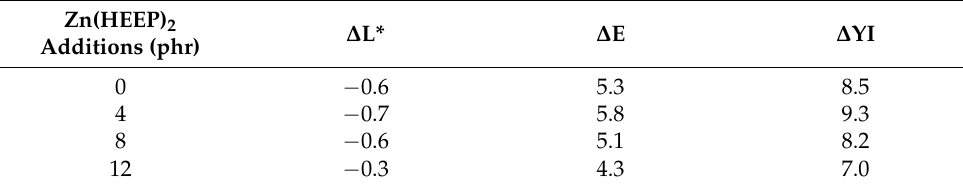
Figure 7. The Tan δ curves of UV films with different Zn(HEEP) 2 additions. The lightfastness parameters of the UV film with different Zn(HEEP) 2 additions after 100 h exposure to the UV light are listed in Table 4. The results showed that the lightness difference ( ∆ L*) of UV films were − 0.3 to − 0.7, indicating that the films were slightly darker after UV irradiation. However, the film containing 12-phr Zn(HEEP) 2 had the lowest values of ∆ L*, color difference ( ∆ E), and yellow index difference ( ∆ YI) of − 0.3, 4.3, and 7.0, respectively, which were lower than those of raw UV films of − 0.6, 5.3, and 8.5. The results revealed that the UV film with the most content of Zn(HEEP) 2 in this study had the best lightfastness. Table 4. The lightfastness of UV film with different Zn(HEEP) 2